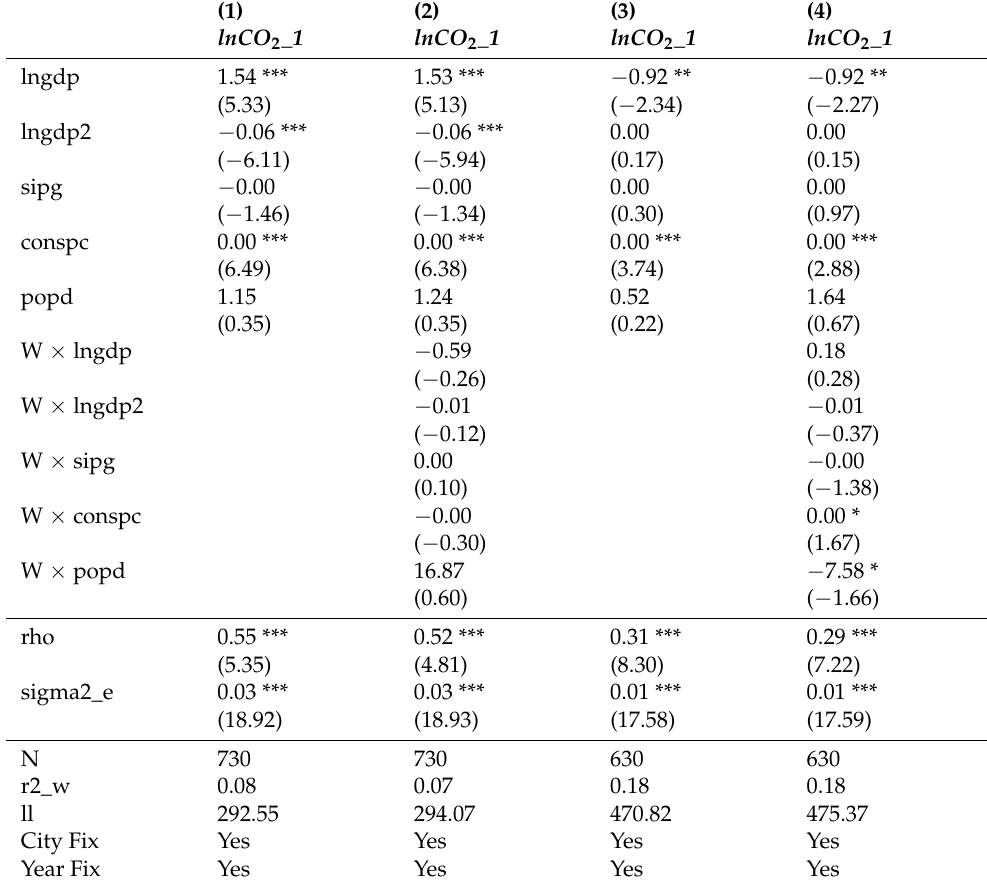
Table 6. Robustness test—replace the dependent